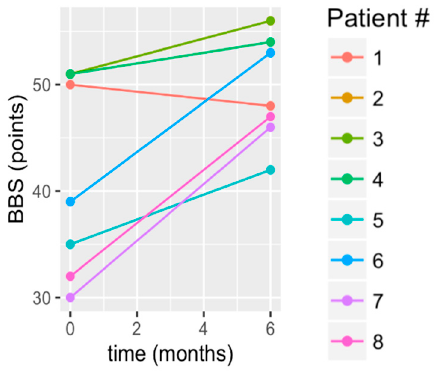
Figure 2. Change in Berg Balance Scale (BBS) from baseline to 6 months. S2 and S4 had identical baseline and 6 month scores, which is why S2’s data are obscured beneath S4’s data. Table 3. Clinical and Measurement Benchmarks for Study